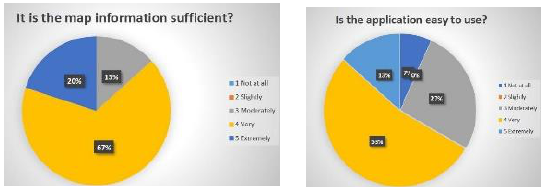
Figure 14. Pie charts concerning the sufficiency of given information and the easiness in use of MEDWINET